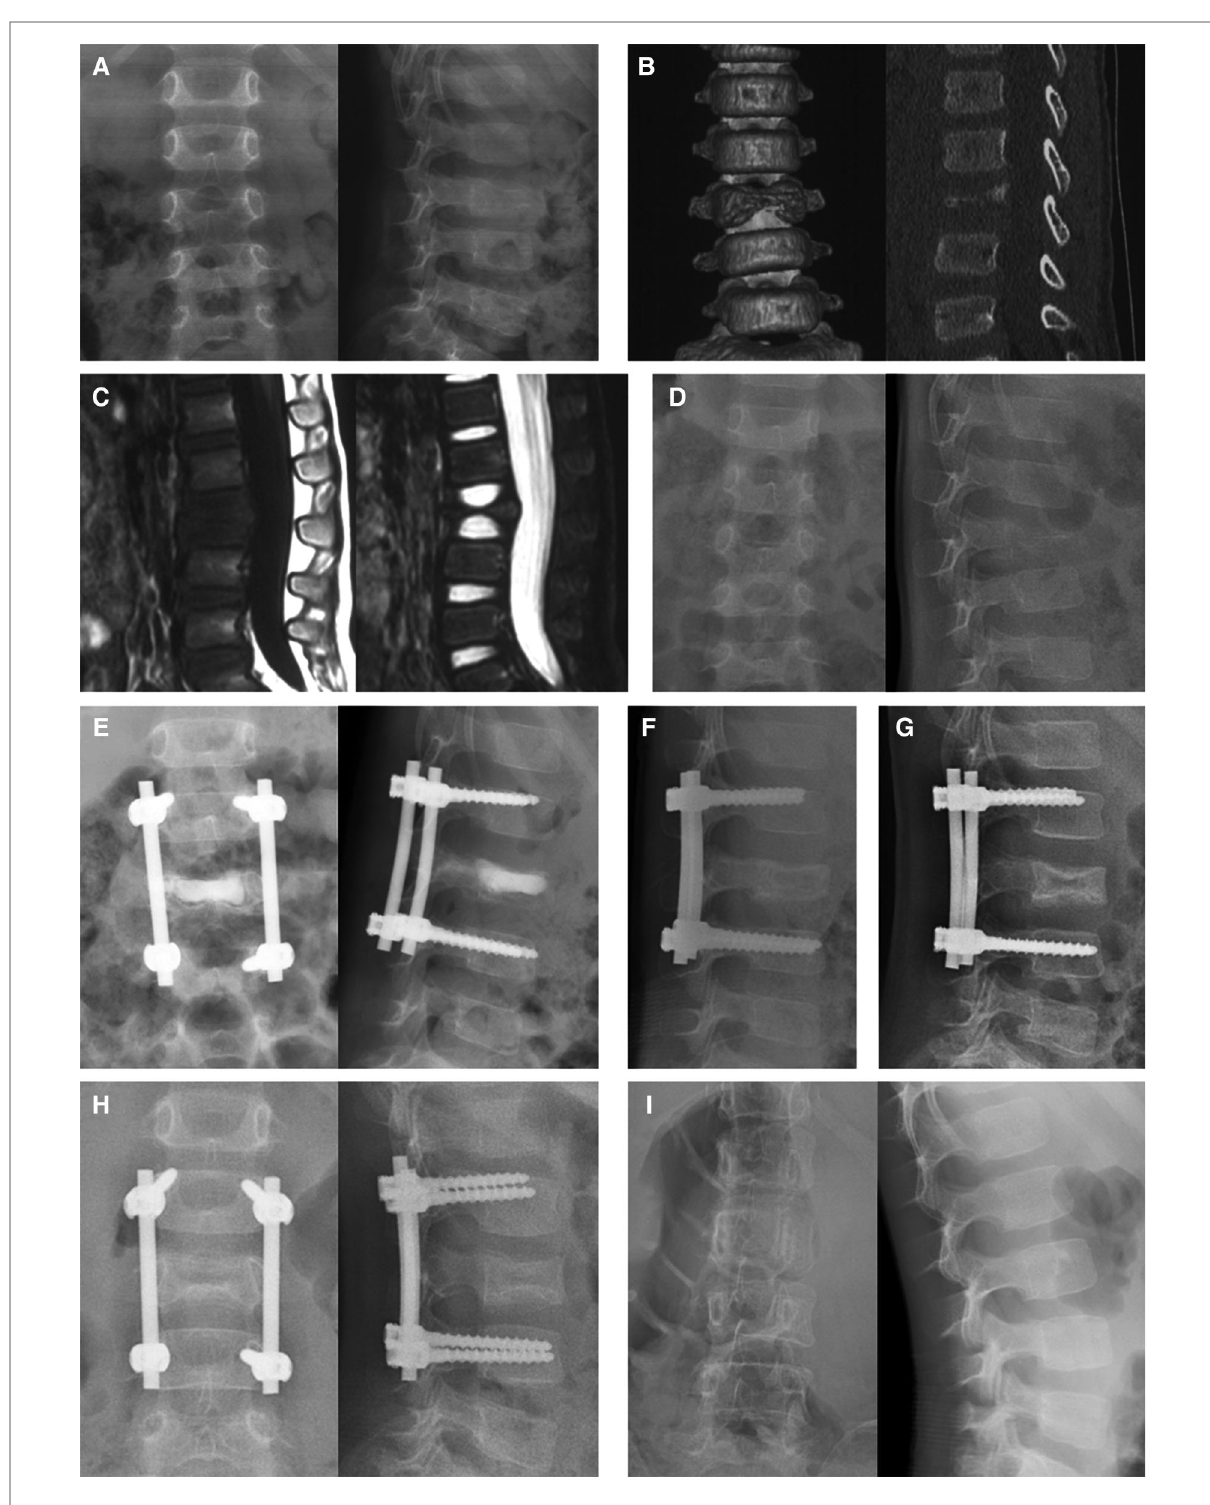
FIGURE 2 Series images of case 1, a 36-month-old boy with L3 vertebra plana. The patient took the plain x-ray ( A ), CT ( B ), and MRI ( C ) in the local hospital 2, 3, and 4 weeks after the symptom of back pain presented, respectively. These series images showed the aggravating damage of the L3 vertebra body. Two months after the initial symptom, the x-ray image ( D ) showed Grade IIA destruction of the L3 vertebral body. Immediately after the operation, vertebral height was partly restored ( E ). The calcium sulfate cement was completely absorbed in the 3-month follow-up ( F ). The vertebral height increased at the 6-month follow-up and osteosclerosis was observed ( G ). One year after the operation ( H ), an 89.2% recovery of vertebral height was observed and then the internal fi xations were removed. Two years after the fi rst operation ( I ), the vertebral body was well